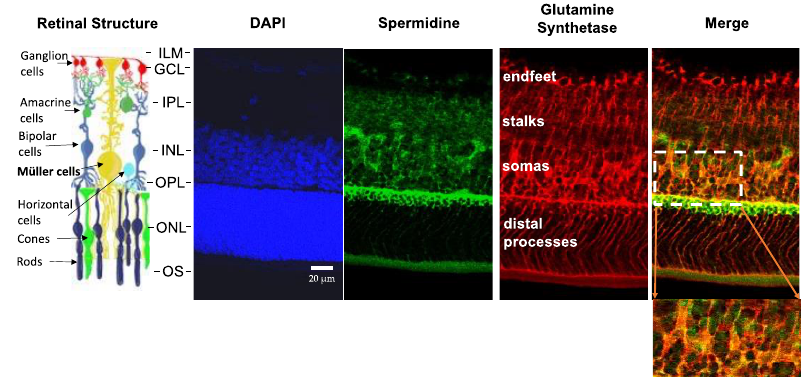
Figure 1. Spermidine (SPD) and Glutamine Synthetase (GS) immunolabeling in a 3-day-old (new- born: P3) rat retina. DAPI (blue) is a nuclear stain. SPD (green) is expressed in the neuroblast layer (NBL) surrounding cell nuclei and within the soma of some cells in the outermost part of the NBL. The SPD expression in these cells is co-localized with glial marker GS (red). Co-localized staining (merged, yellow). SPD is also expressed in the inner plexiform layer and in the ganglion cell layer, surrounding the cells. (GCL—Ganglion Cell Layer; IPL—Inner Plexiform Layer; NBL—Neuroblast Layer, proliferative zone of the inner optic cup that consists of retinal progenitor cells).